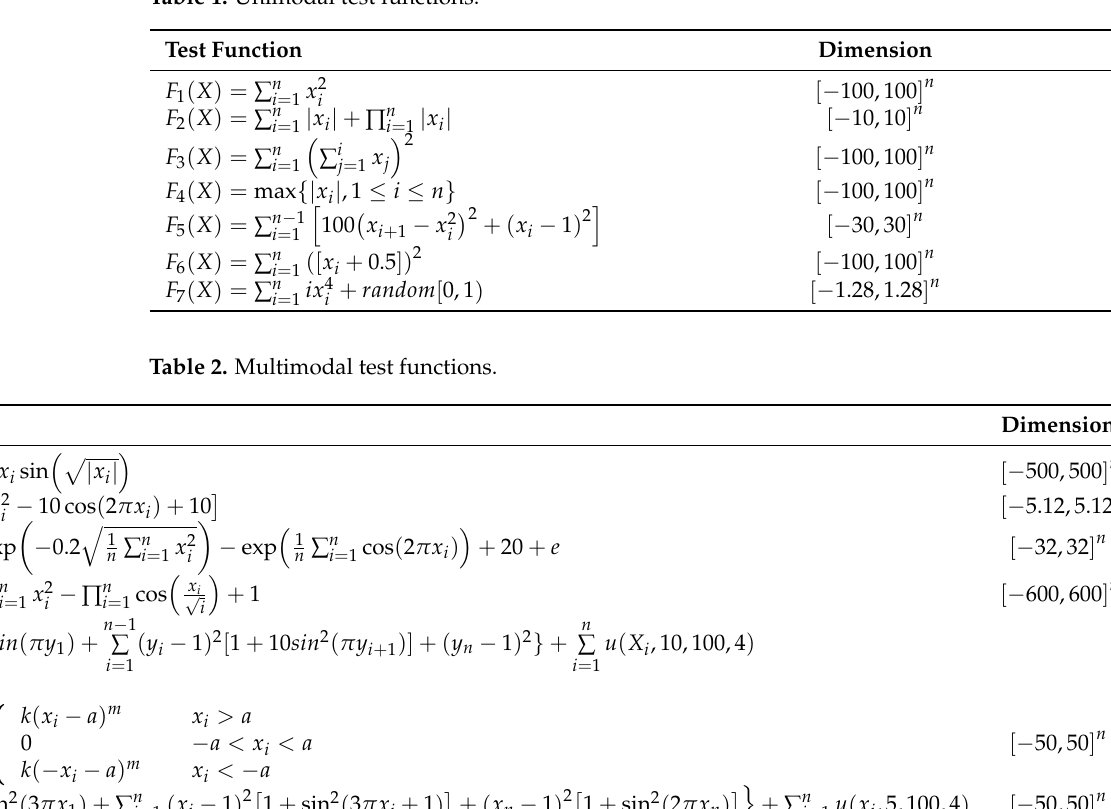
Table 1. Unimodal test functions.